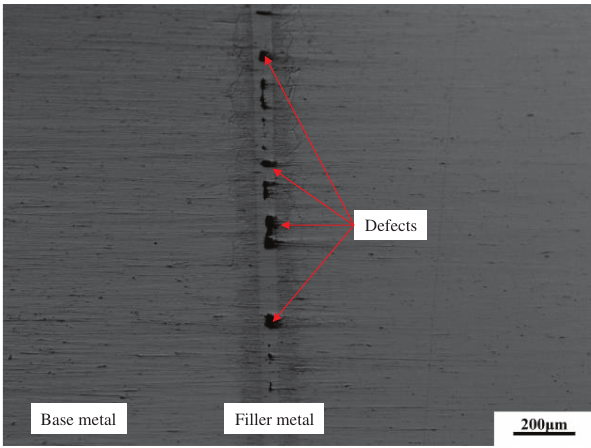
Figure 1: The macrograph of brazed joint containing defects.